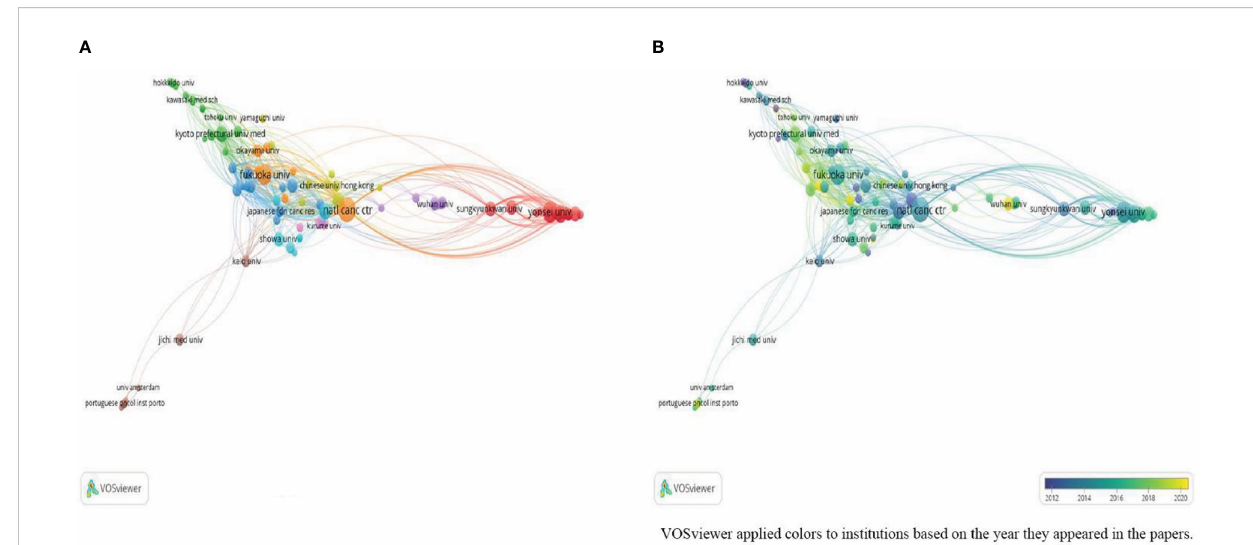
FIGURE 4 (A) Network visualization of institutions; (B) Overlay visualization of